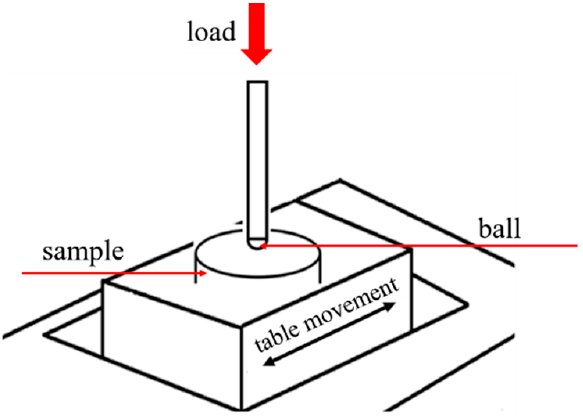
Figure 2. Ball-on-disc configuration. Table 2 compiles the test parameters. The counter-sample in the tested friction pairs was a ball 6 mm in diameter made of Al 2 O 3 (III) with an Ra equal to 0.32 µ m. The tests were repeated five times for each friction pair with the given parameters. The chemical composition of the lubricant used is summarized in Table 3. Table 2. Test parameters.